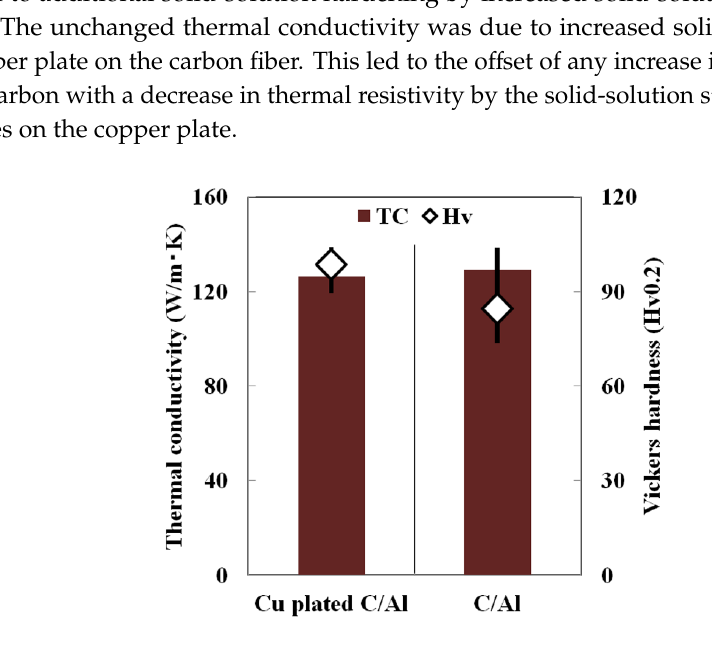
Figure 17. Thermal conductivity of Cu plated C/Al SLM composite fabricated with XD scanning pattern. To gain insight into the observed anisotropic thermal conductivity, the cross-sections of the XD composite for each direction were observed by OM (Figure 18). Note that the beads distribute methodically in planes perpendicular to the stacking direction as a result of only scanning in the x - direction for each layer. As discussed in Section 3.2, the solid-solution content of carbon and copper in the lower tip portions of the beads is expected to be high due to the high solidification rate, leading to lower thermal conductivity. On the other hand, the upper portions also formed in layers could